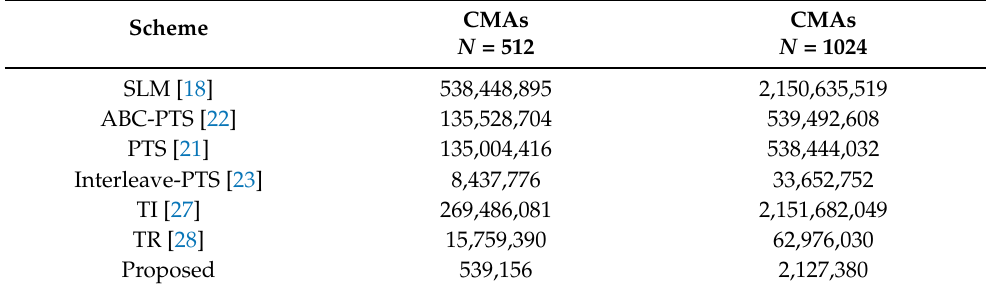
Table 4. The numerical comparison of complexity for different schemes with N = 512 and 1024.